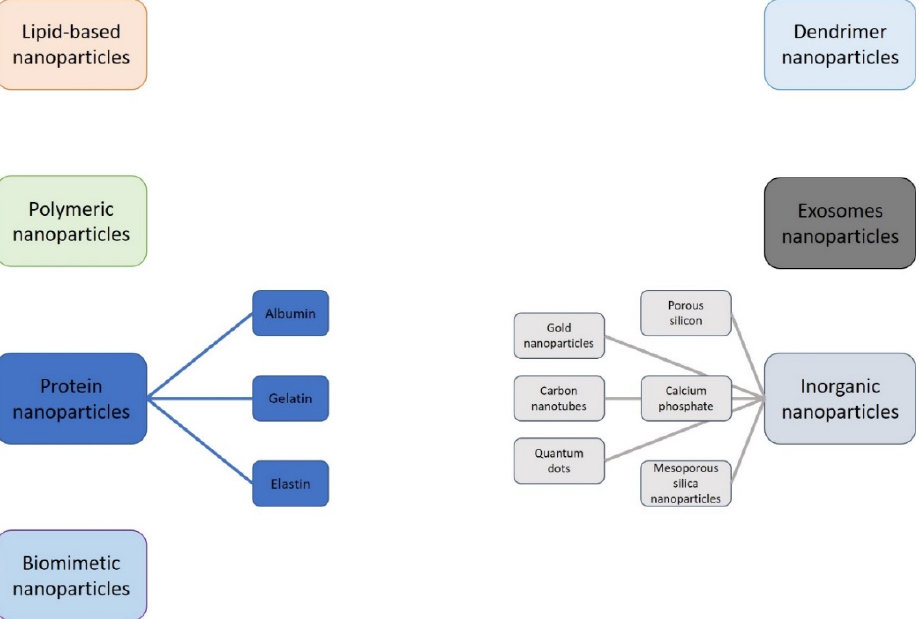
Figure 1. Nanostructures employed in nanomedicine.